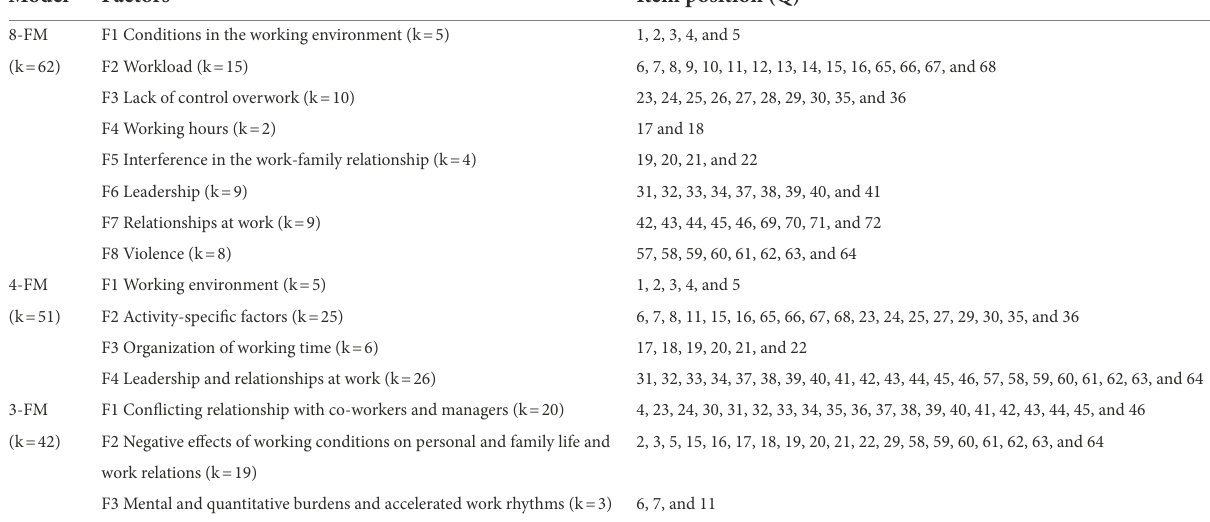
TABLE 2 Factors and items of the 8-FM, 4-FM, and 3-FM models of the